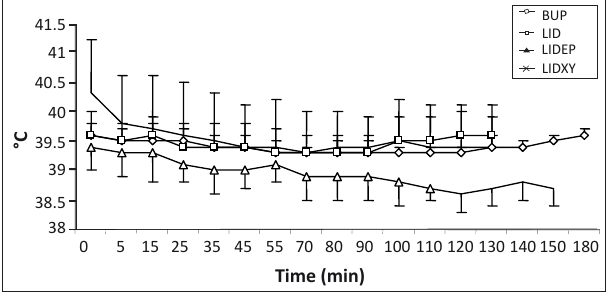
FIGURE 4: Rectal temperature ( mean ± s.d.) in sheep ( n = 6) administered with epidural lidocaine, lidocaine-epinephrine, lidocaine-xylazine or bupivacaine.